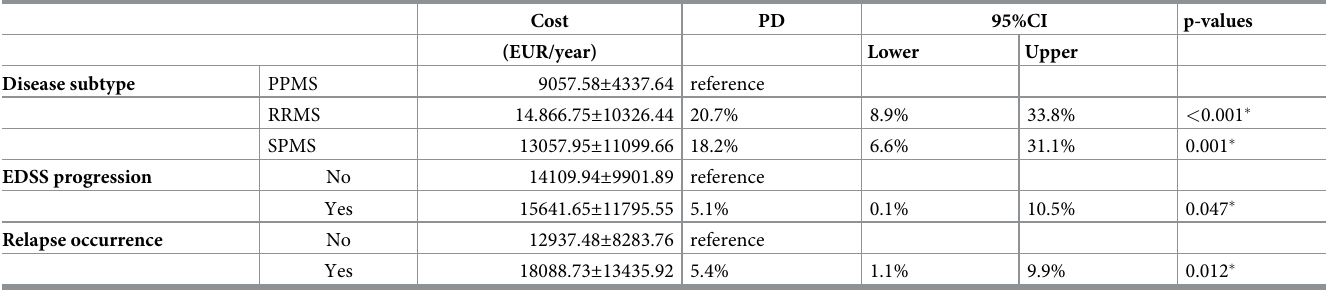
Table 4. Costs and clinical features.